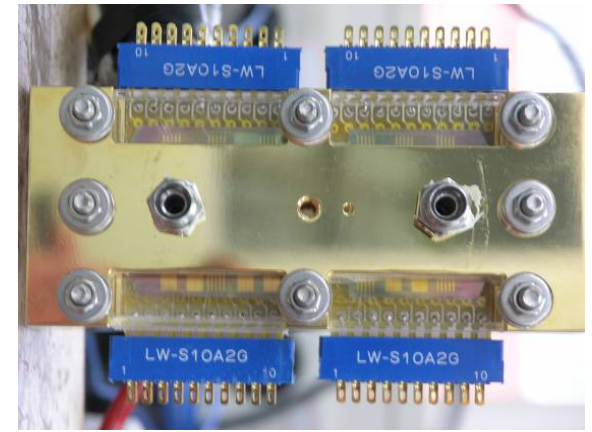
Figure 7. Assembly of single PEM fuel cell with micro sensor